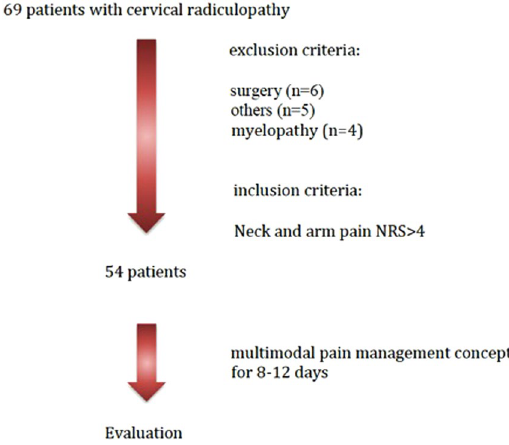
Figure 1. Flowchart of patient inclusion.